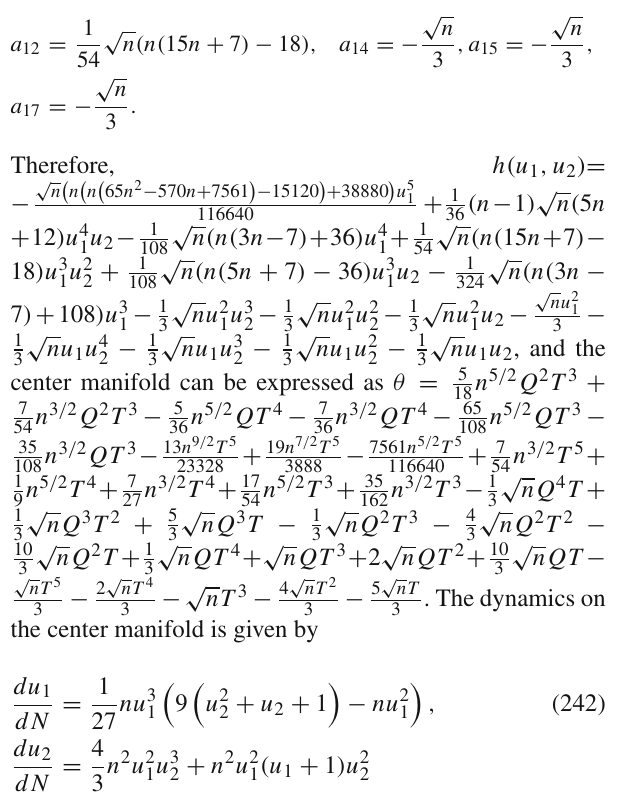
and taking Taylor series near ( u 1 , u 2 , v) = ( 0 , 0 , 0 ) up to fifth order we obtain the system (233), (234), (235) can